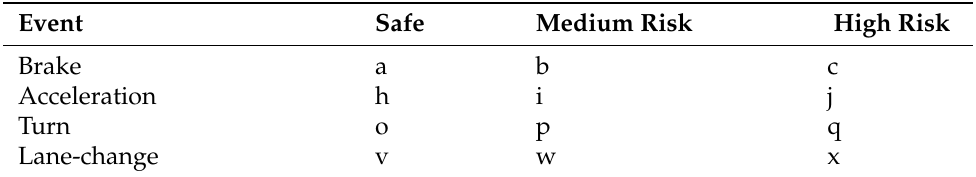
Table 3. Patterns